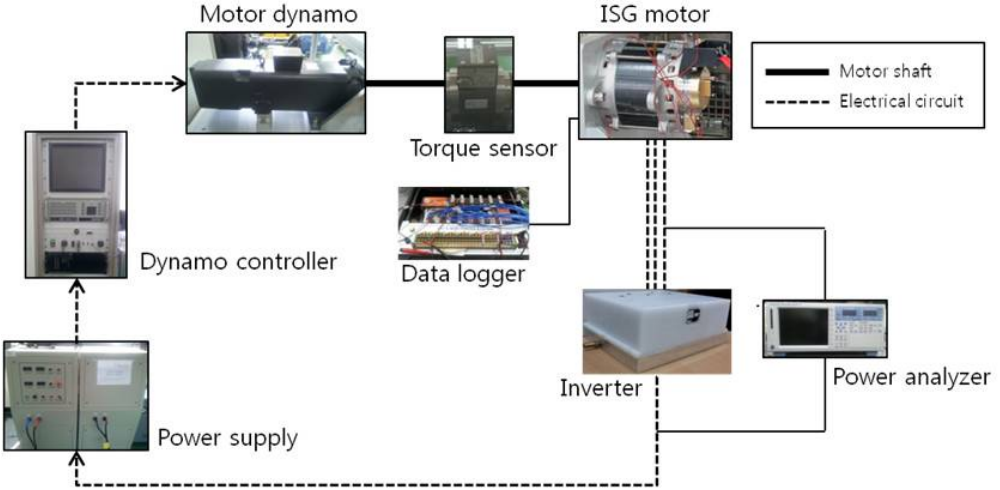
Figure 5. Experimental apparatus to measure motor performance and steady state temperature of the ISG components.